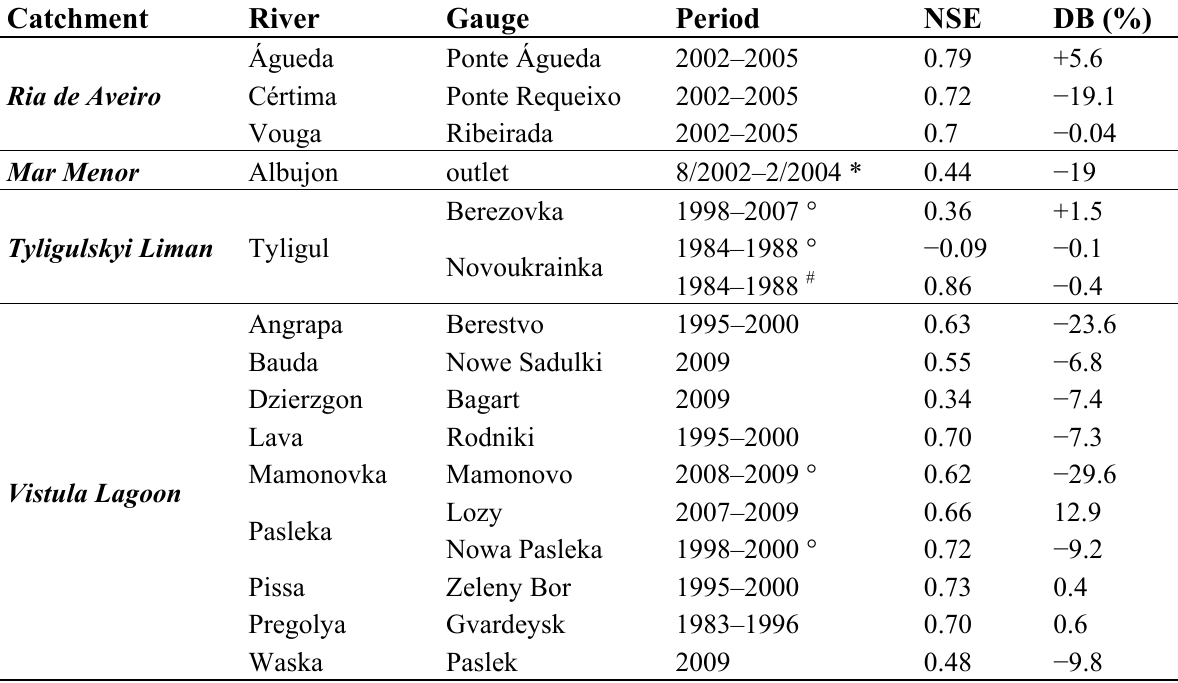
Figure 2. Comparison of the long-term average daily and monthly observed and simulated discharges ( Q ) at selected river gauges in the case study areas. Due to missing daily observed data in the Mar Menor case, the long-term average daily discharge could not be calculated. Table 4. Criteria of fit achieved at all gauges with available water discharge data applying basin-wide calibration parameter sets in the lagoon case study